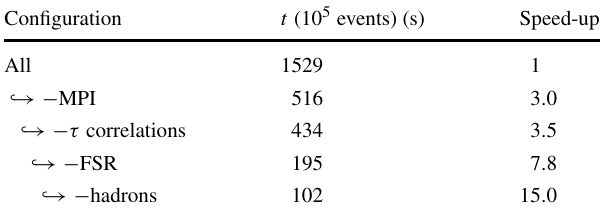
Table 2 Single-thread CPU effects of sequentially disabling event sim- ulation components, for 100,000 SUSY events at the SPS1a parameter point [83,84], including all sub-processes. The disabled components have a major effect on CPU, and a minor (sometimes even positive) effect on physics performance. The third row corresponds to the first row in Table 1. Note that the few percent difference is typical of the variation with local CPU load on the cluster on which this was